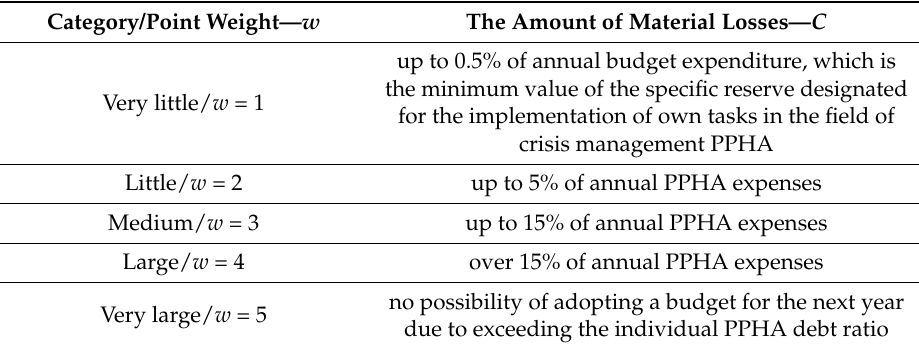
Table 2. Category of material